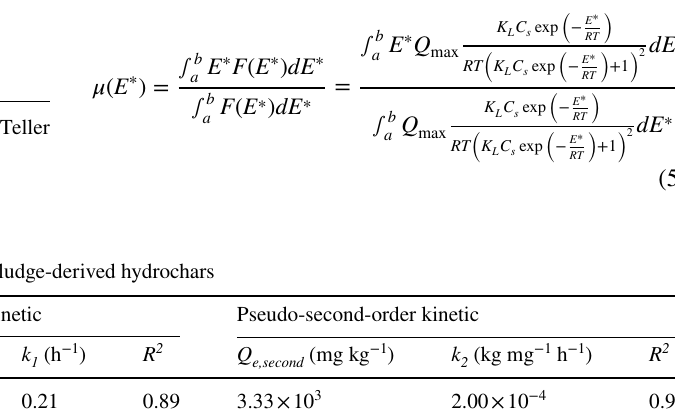
Table 5 Sorption isotherm parameters of Cd 2+ to fresh and aged sludge-derived hydrochars